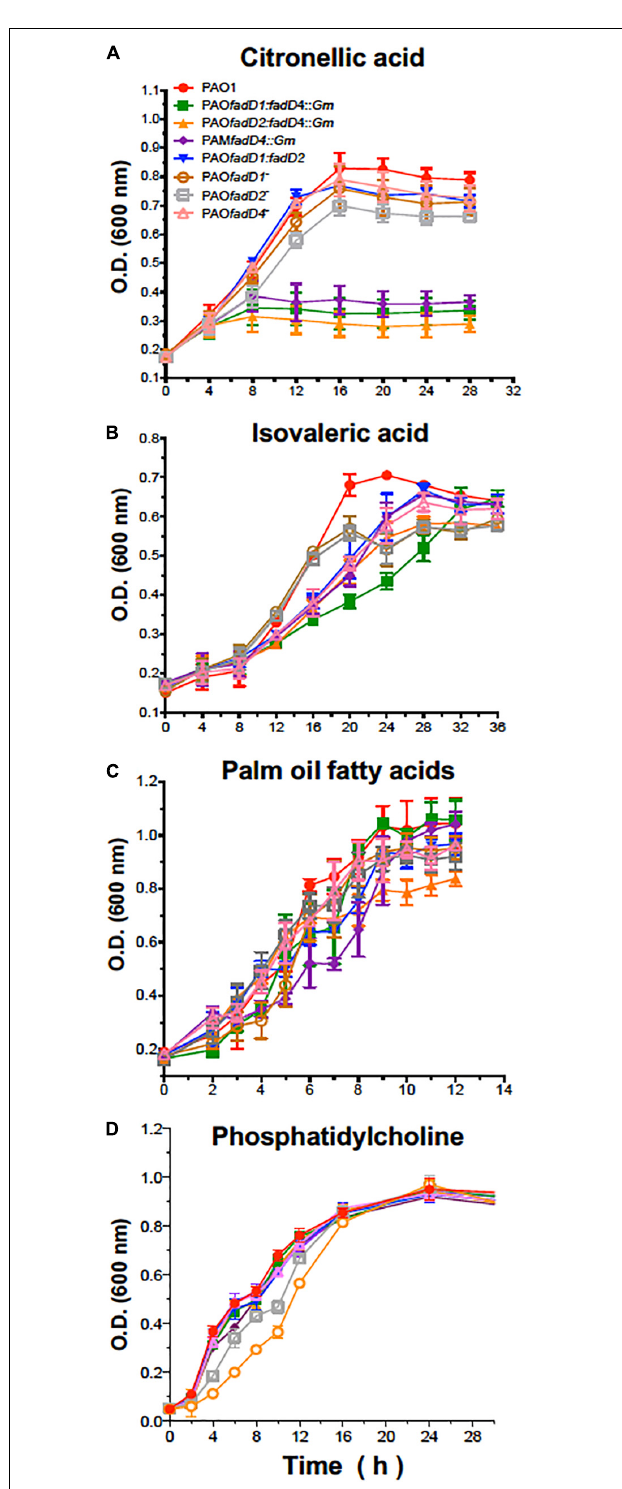
FIGURE 3 | Bacterial growth of P. aeruginosa PAO1-derived strains. Cultures were grown on M9 minimal medium with 0.1% citronellic acid (A) , 0.1% isovaleric acid (B) , 0.1% oil fatty acids (C) , or 0.4% phosphatidylcholine (D) at 30 ◦ C with shaking. Results are shown as means ± SE of triplicate